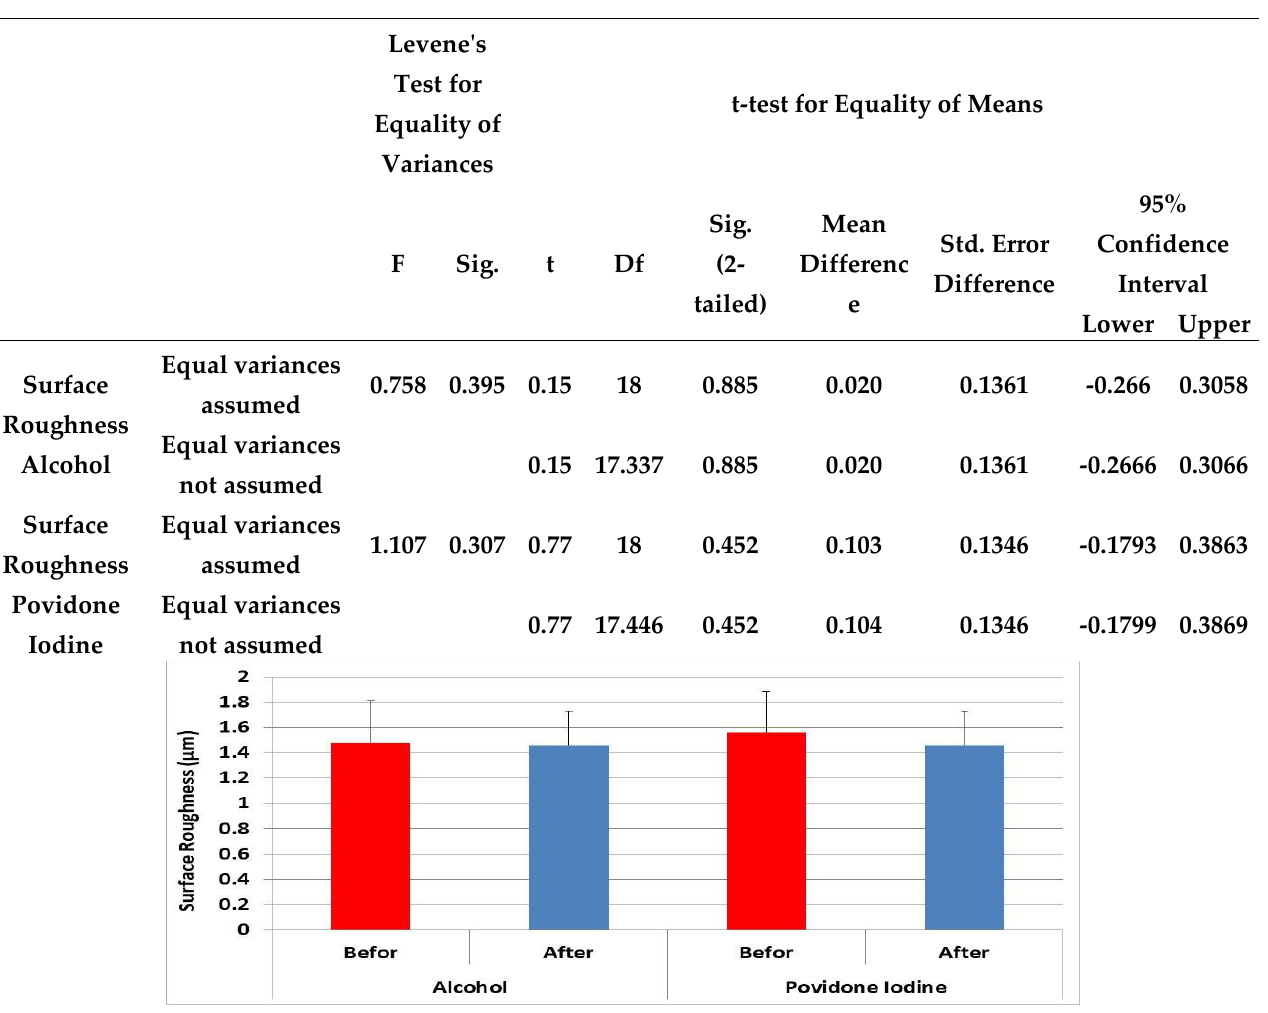
Figure (8): Bar chart of mean values for experimental